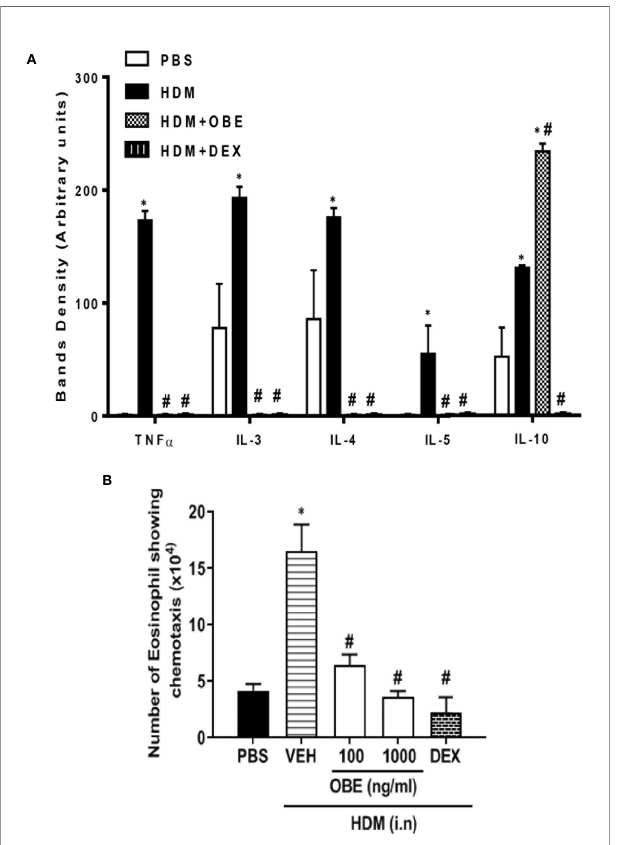
FIGURE 7 | (A) Effect of OBE treatment (60 mg/kg; i.p.) on the airway expression of various pro-in fl ammatory cytokines. HDM challenge signi fi cantly enhanced the expression of the following interleukins (IL): IL-3, IL-4, IL-5, IL-10, and tumor necrosis factor (TNF- a ). Treatment with OBE signi fi cantly reduced the expression of these cytokines except IL-10 which was signi fi cantly increased above the HDM levels. Data are expressed as mean ± SEM (n = 4). *P < 0.05 vs PBS group, # P < 0.05 vs HDM group. (B) Effect of OBE (100 and 1,000 ng/ml) on HDM/BALF-induced eosinophil chemotaxis. BALF from HDM-challenged mice induced a signi fi cant increase in eosinophil chemotaxis compared to BALF from PBS-challenged mice. Pretreatment with OBE (100 and 1,000 ng/ml) dose- dependently inhibited eosinophil chemotaxis. Data are expressed as mean ± SEM ( n = 5). *P < 0.05 vs PBS group, # P < 0.05 vs HDM group.